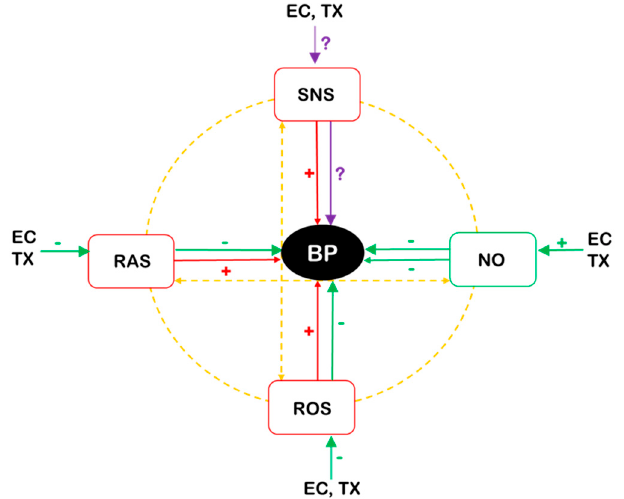
Figure 1. Scheme of interactions among the main blood pressure regulatory systems and reactive oxygen species. The SNS, RAS, ROS, and NO all participate in blood pressure regulation and interact with each other (orange lines). EC and TX were shown possess antioxidant properties and to reduce ROS. EC and TX also inhibit the RAS and elevate NO production (green lines). The SNS, RAS, and elevated ROS are known to elevate blood pressure (red lines). The effects of EC and TX directly on the SNS are unclear. Abbreviations: BP, blood pressure; EC, ( − )-epicatechin; NO, nitric oxide; ROS, reactive oxygen species; SNS, sympathetic nervous system; RAS, renin–angiotensin system; TX, (+)-taxifolin, ( − )-taxifolin or their racemic mixture.